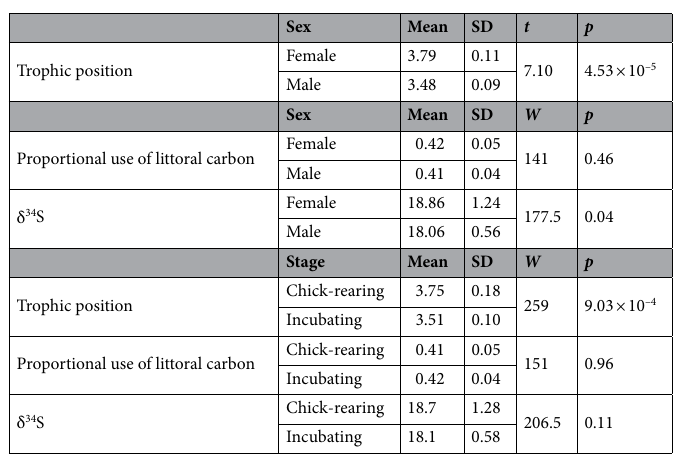
Table 1. Comparison of stable isotope values between sexes and reproductive